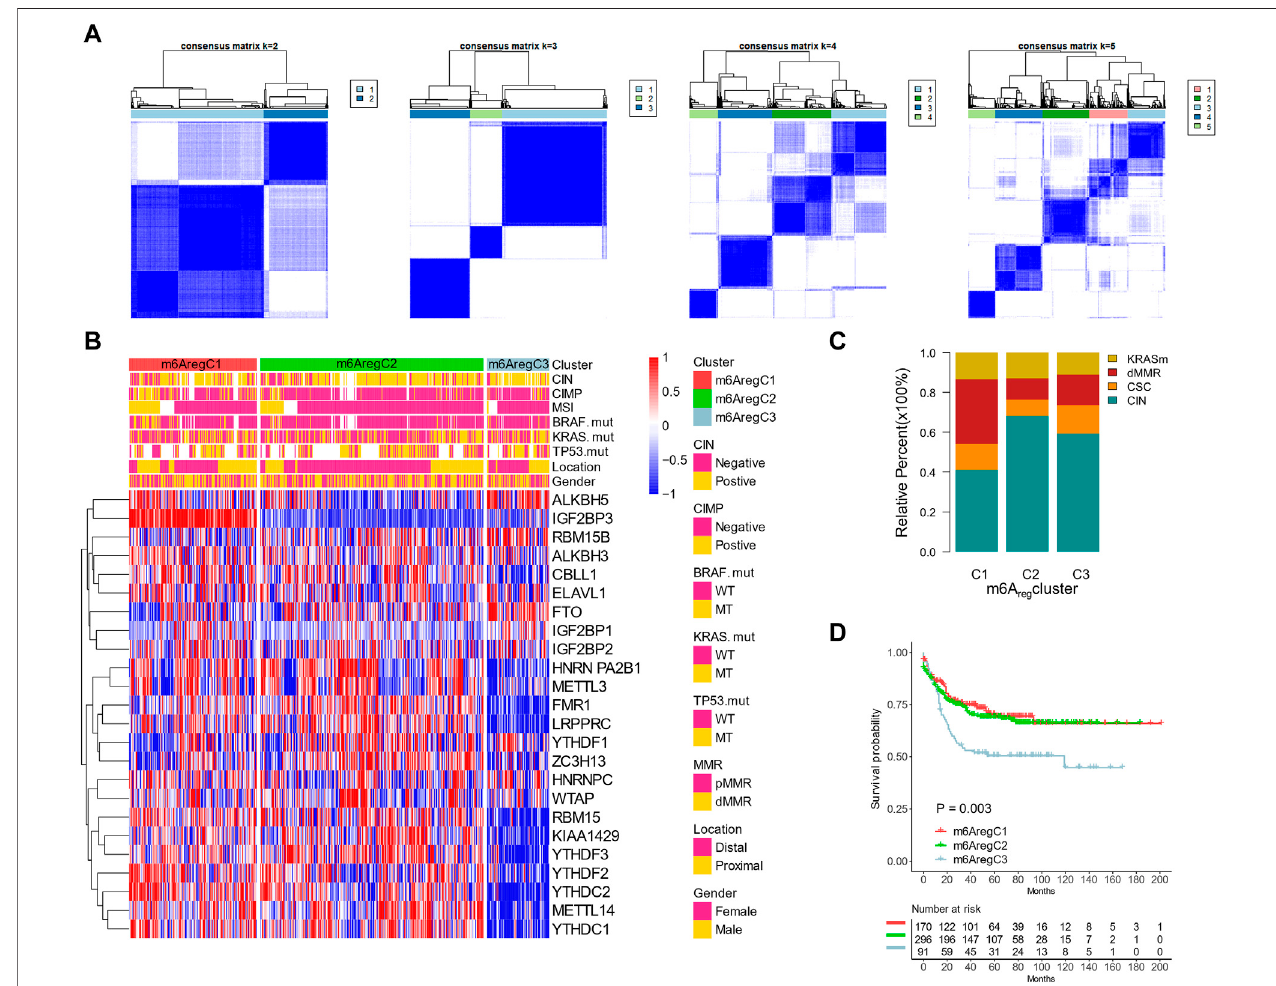
FIGURE3| Associationbetweenm 6 Aregulator – basedsubtypesandtumormicroenvironmentcomposition. (A) Unsupervisedclusteringbasedonm 6 Aregulators with n = 2 to 5 in the GSE39582 data set. (B) Clustering m 6 A regulators into three subtypes. Distribution of molecular subtypes (chromosomal instability, CpG island methylator phenotype, and microsatellite instability) and driver mutations (KRAS, RBAF, and TP53) were provided. (C) Distribution of genetic change types in three m 6 A regulator – based subtypes. (D) Kaplan – Meier curves of the three m 6 A regulator – based subtypes.